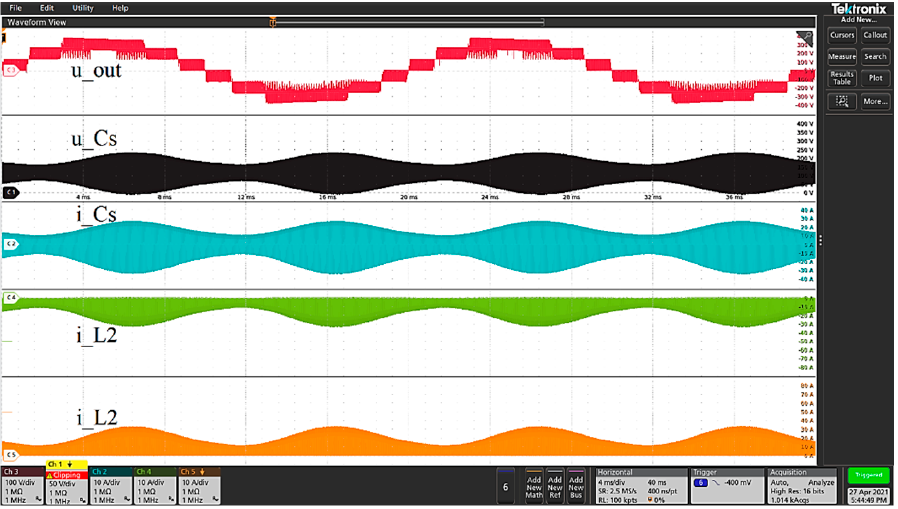
Figure 24. Operation of the AIVB with constant switching frequency. Waveforms of the output voltage of the inverter ( u out [100 V/div]), voltage and current of the switched capacitor ( u CS [50 V/div], i CS [10 A/div]) as well as currents of resonant chokes ( i L1 [10 A/div], i L2 [10 A/div]).